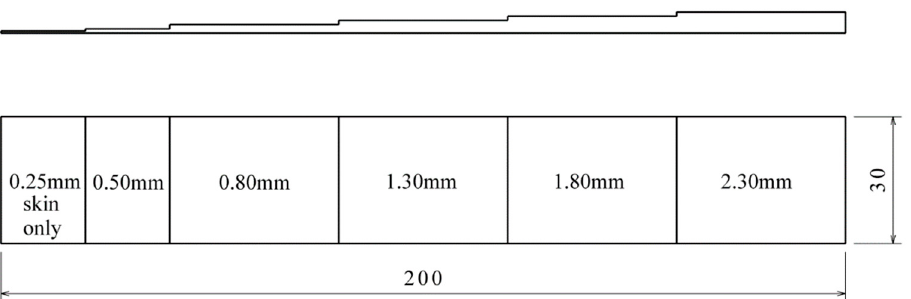
Figure 8. Dimensions of the reference gauge.